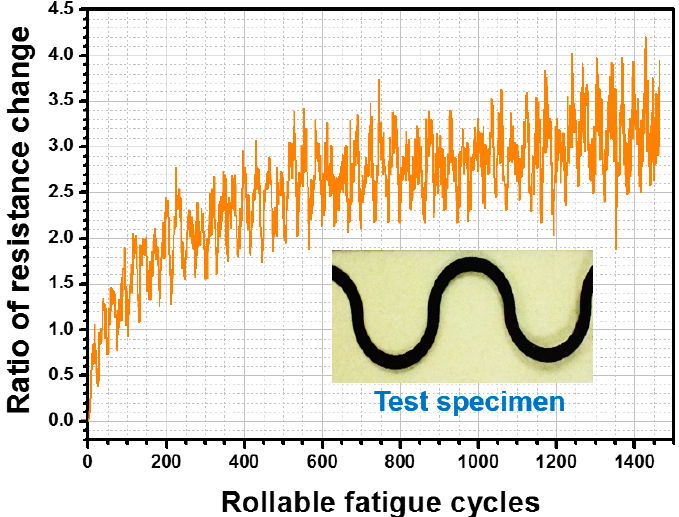
Figure 13. Experimental results of graphene ink interconnect after rollable cyclic loading was applied.